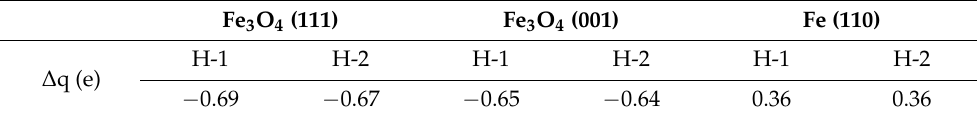
Table 3. Bader charge transfer for H interacting on Fe (110) and Fe 3 O 4